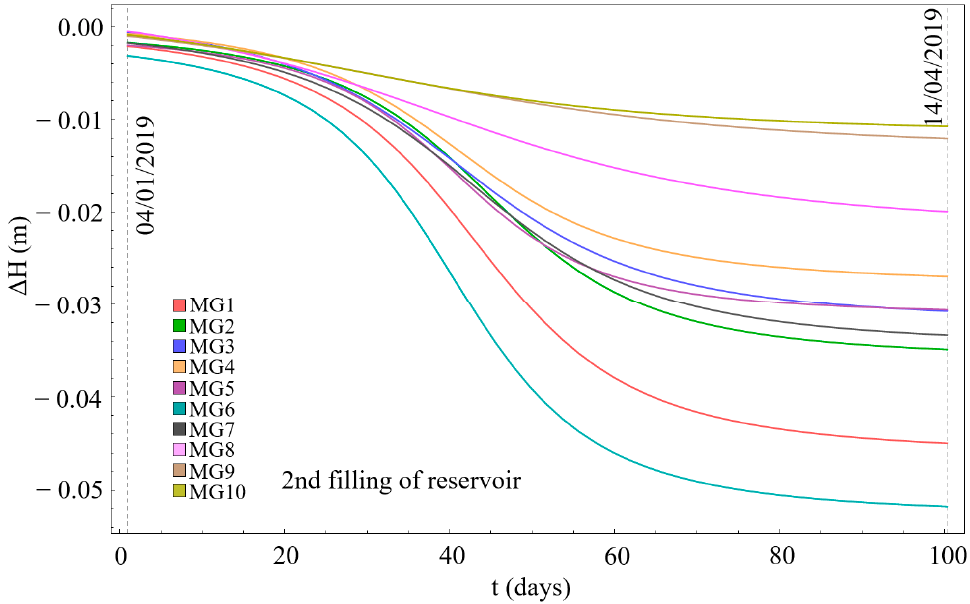
Figure 14. Fitted FNSE models for points MG1 to M10, from 04 / 01 / 2019 to 14 / 04 / 2019.